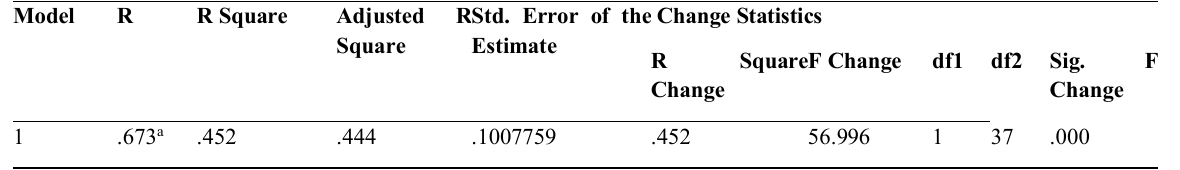
Table 2: Regression of stakeholder involvement and tourism performance